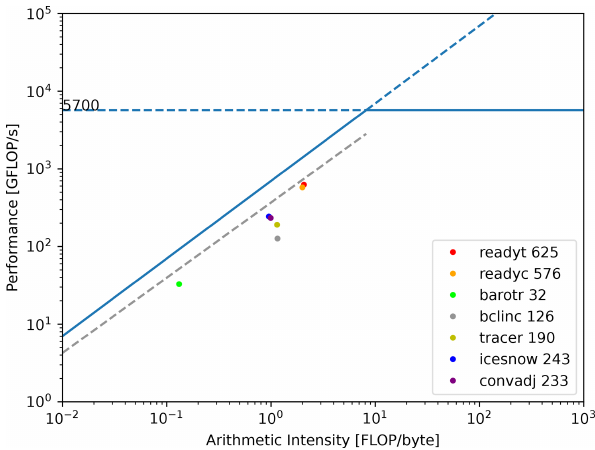
Figure 9. Roofline model for the AMD GPU and the performance of LICOM’s main